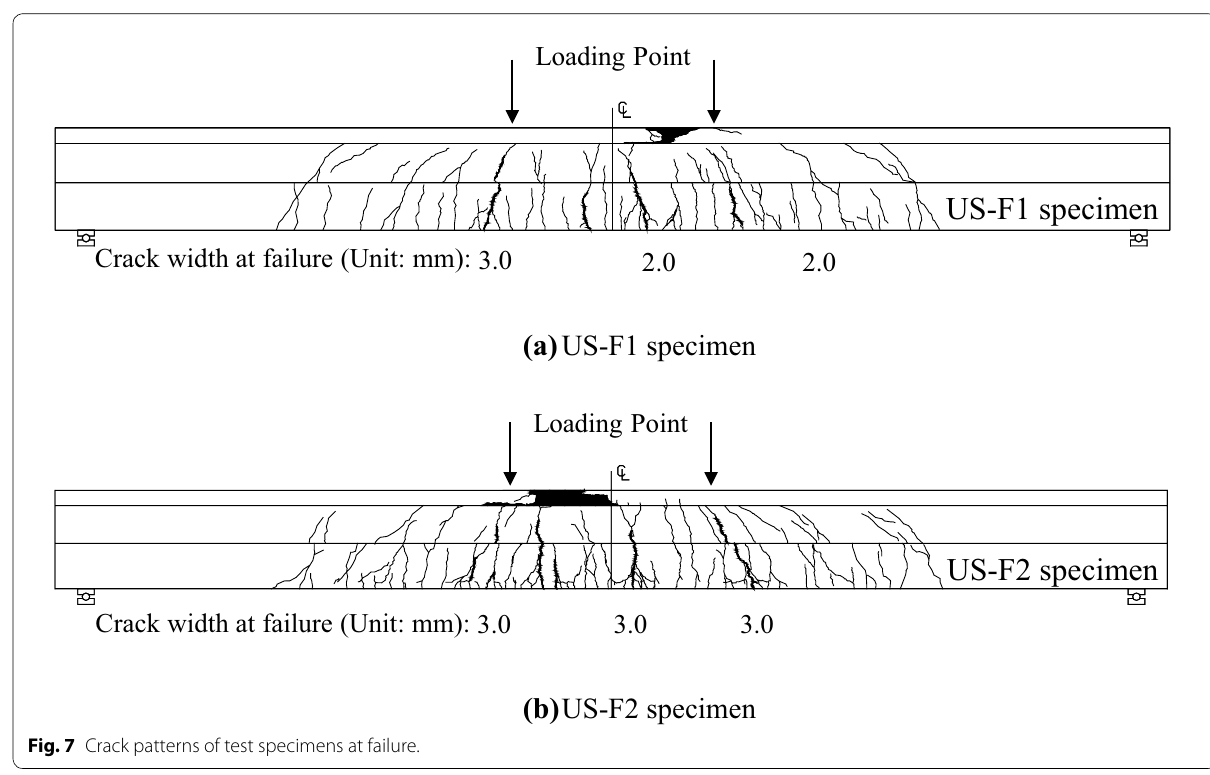
Fig. 7 Crack patterns of test specimens at failure.